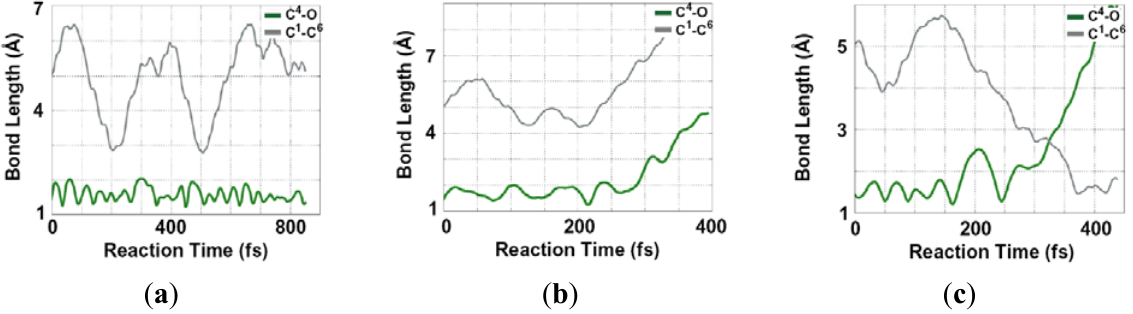
Figure 5. Bond length changes of C 4 -O bond (green curve) and C 1 -C 6 bond (gray curve) observed in the DRC trajectories with initial kinetic energies of ( a ) 8 kcal/mol, ( b ) 10 kcal/mol, and ( c ) 12 kcal/mol.